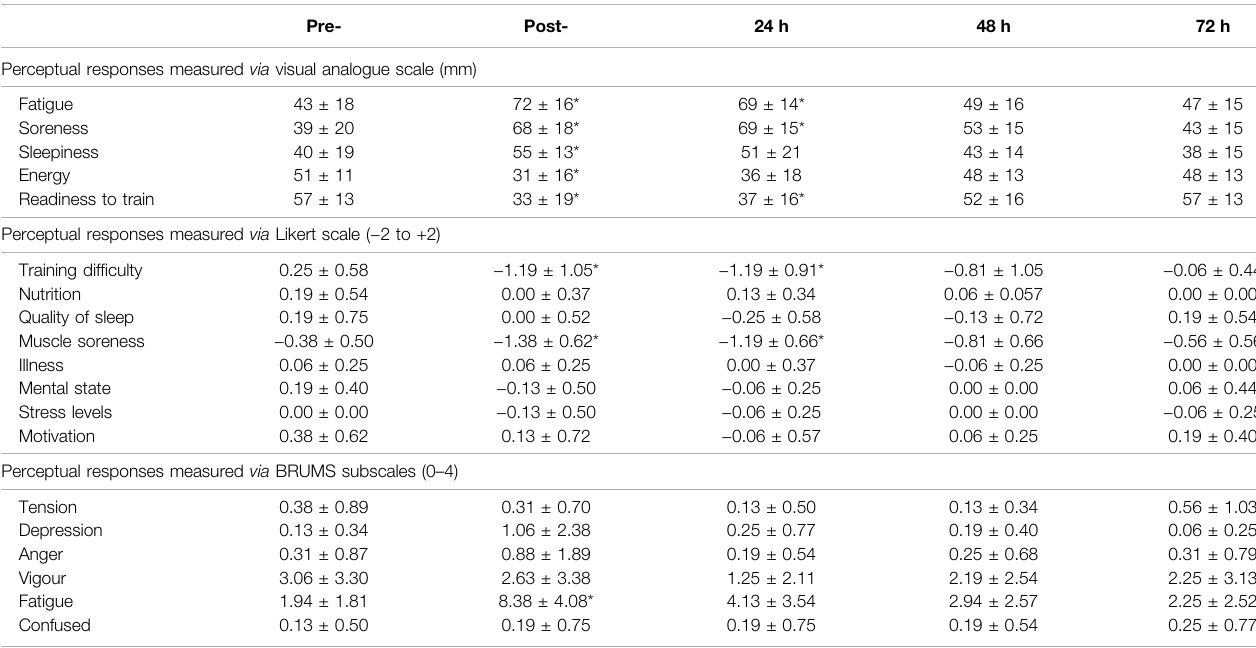
Values are mean ± SD. Signi fi cant differences in comparison with baseline indicated by * p < 0.05.